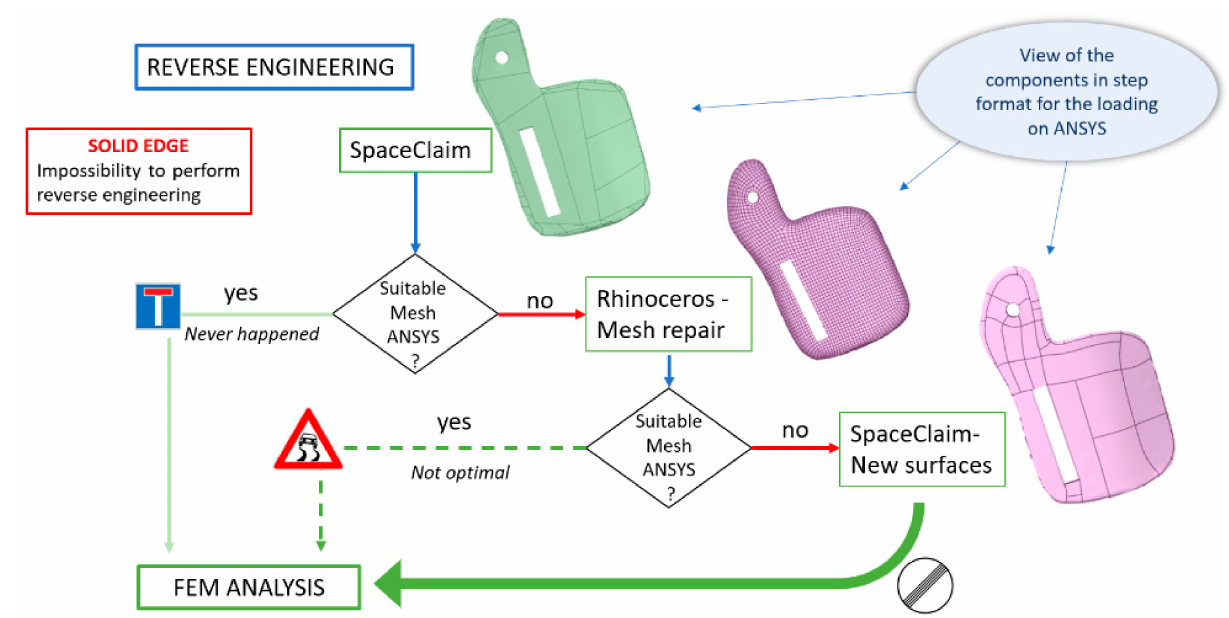
Figure 4. The final procedure for reverse engineering.